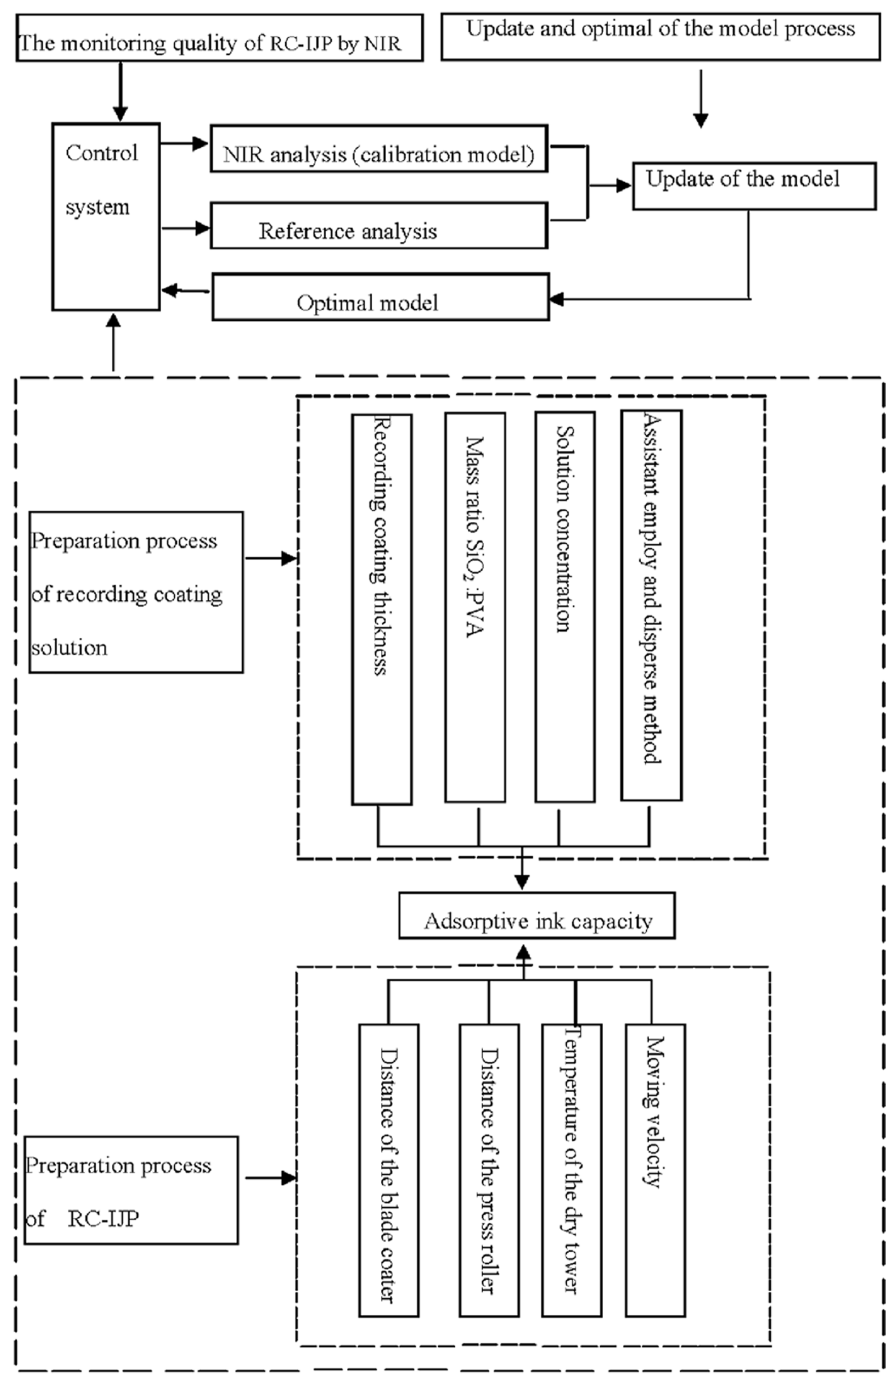
Figure 7. Sketch of monitoring quality of RC-IJP.